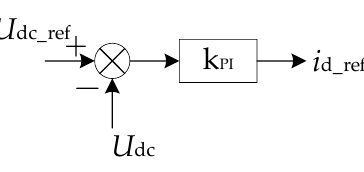
Figure 14. System-level control diagram.